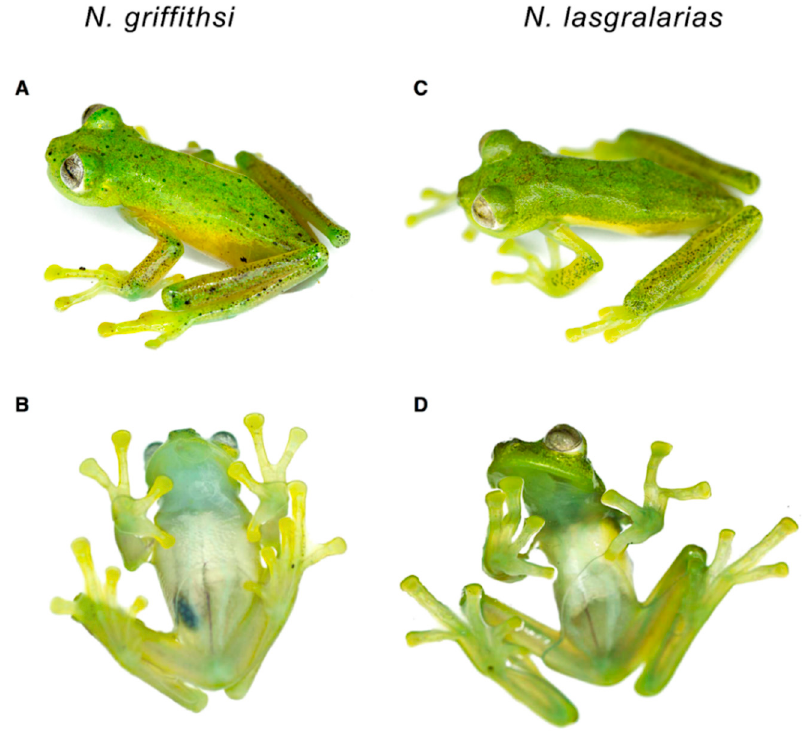
Figure 154. ( A , B ) Nymphargus griffithisi in life, MZUTI 099. ( C , D ) Nymphargus lasgralarias in life, MZUTI 094. Photos of both species from Reserva Las Gralarias, 2175–2200 m, Pichincha province, Ecuador. Photos by Carl R. Hutter.